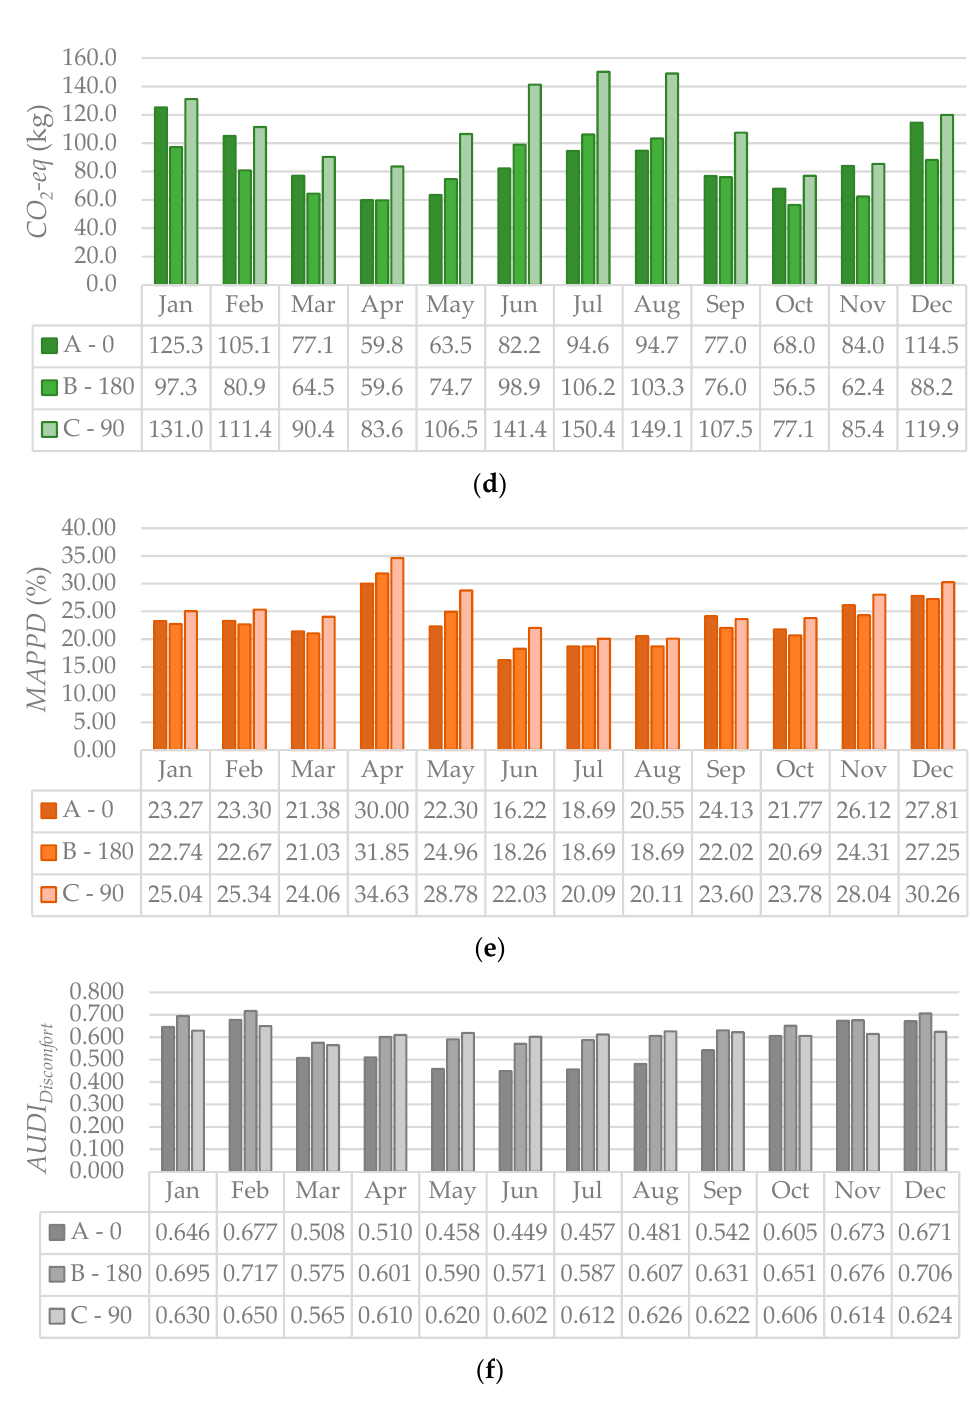
Figure 10. Monthly results of the objective functions for the optimal orientations of the three different building types, including, types A, B, and C: ( a ) monthly results of Q l ; ( b ) monthly results of Q h ; ( c ) monthly results of Q c ; ( d ) monthly results of CO 2 -eq ; ( e ) monthly results of MAPPD ; ( f ) monthly results of AUDI Discomfort